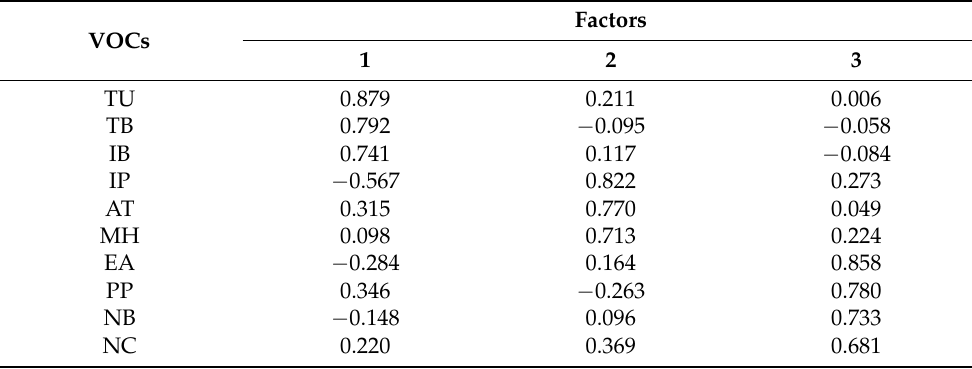
Table 3. Loading matrix of the three